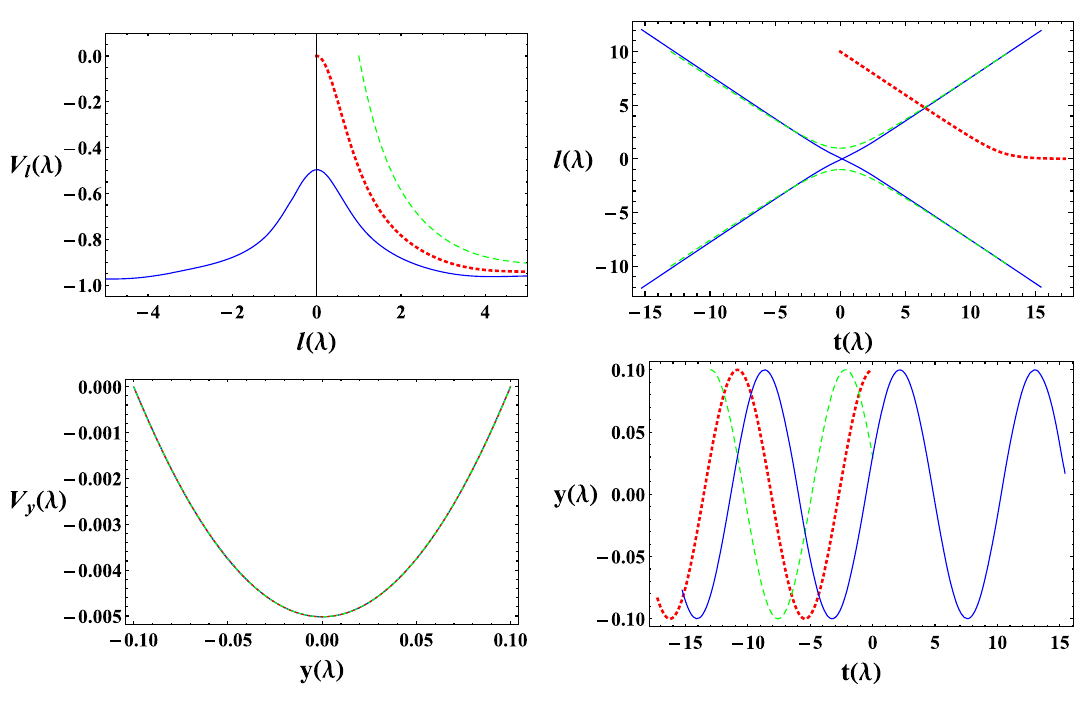
Fig. 9 Geodesics and effective potential for 5D-WEB model with growing warp factor: dotted-red, dashed-green, and continuous-blue curves representing – Trapped, Returning and Crossing geodesics